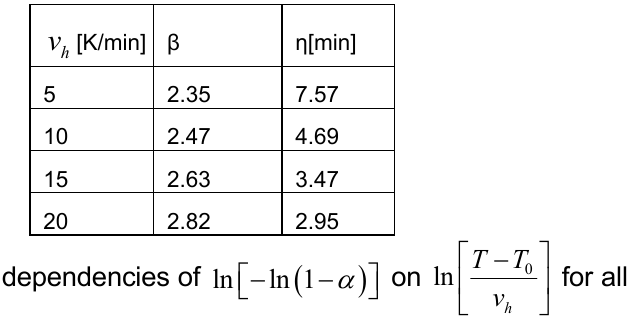
Table 2 – Values of the Weibull’s parameters at different heating rates Таблица 2 – Значения параметров Вейбулла при разных скоростях нагревания Табела 2 – Вредности Вејбулових параметара на различитим брзинама